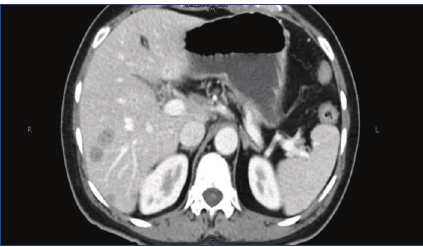
Figure 7: Skin biopsy. Vasculitis involving the superficial and deep dermis showing fibrinoid necrosis of vessel wall with granuloma formation, neutrophilic infiltrate, and nuclear